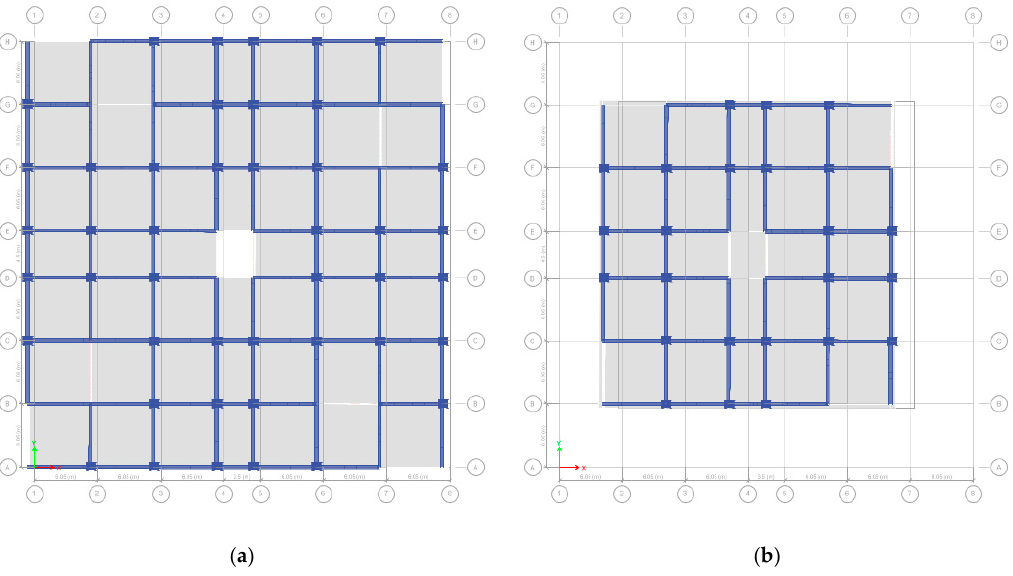
Figure 17. The 1st mode shape for T 1 = 0.519 s: ( a ) plane view of the 1st floor, and ( b ) plane view of the 10th floor.